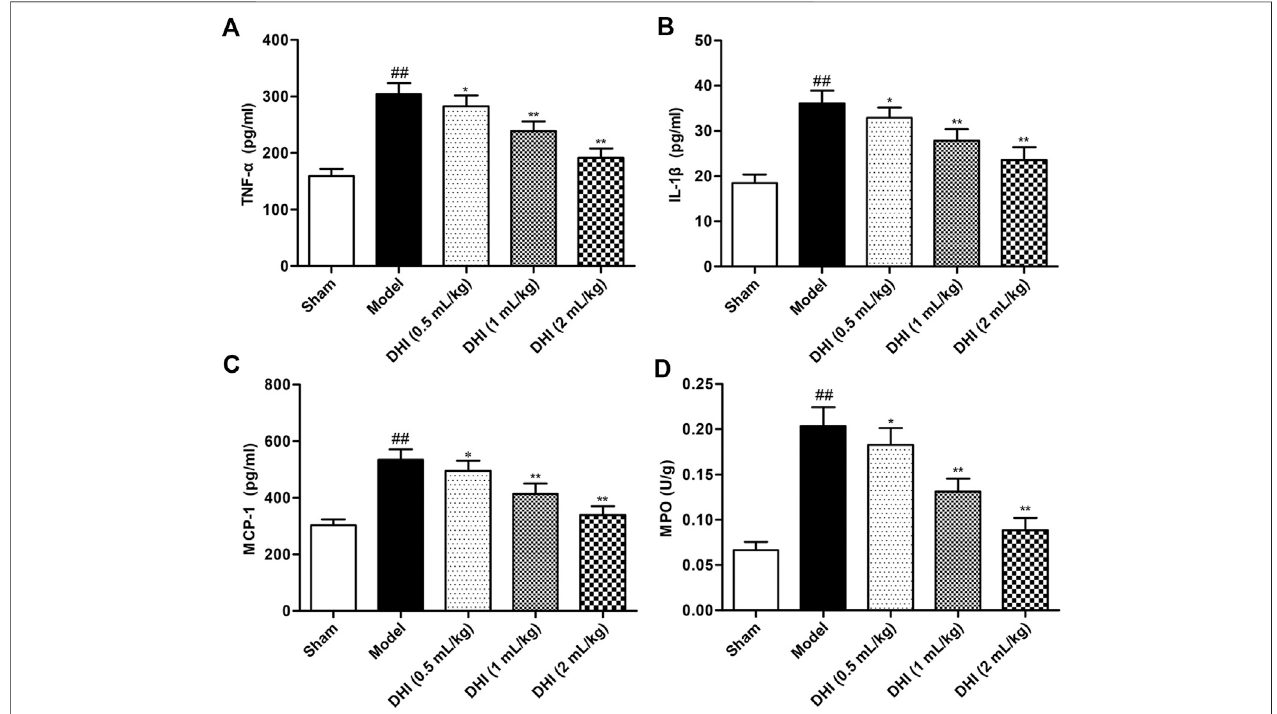
Frontiers in Pharmacology |